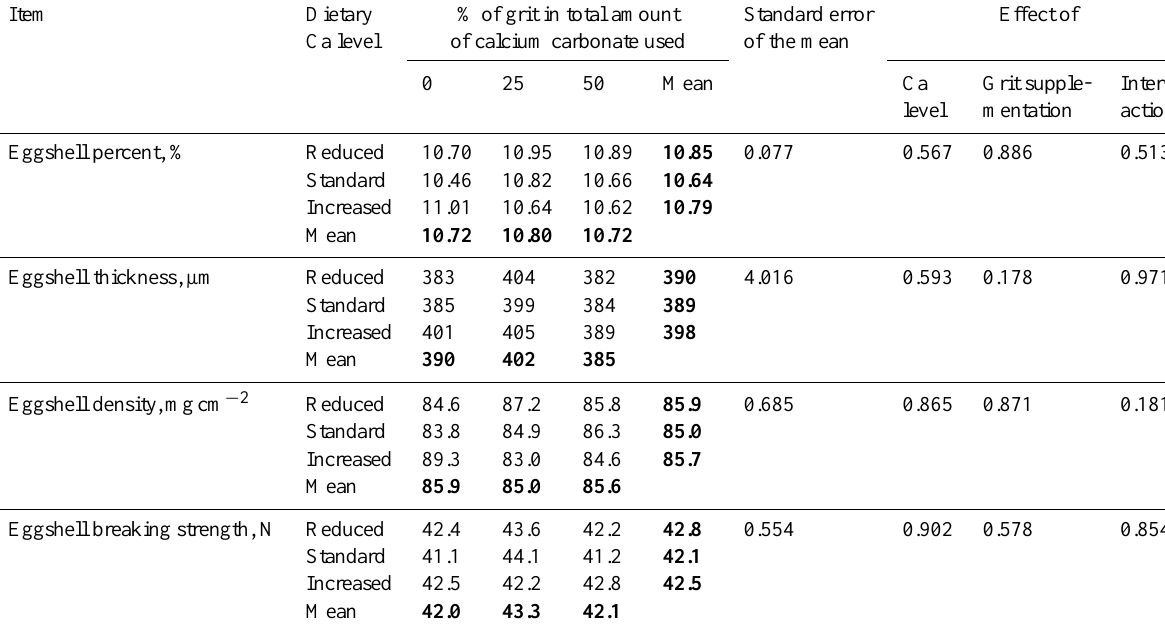
Table 3. Effects of dietary treatments on eggshell quality at 43 weeks of